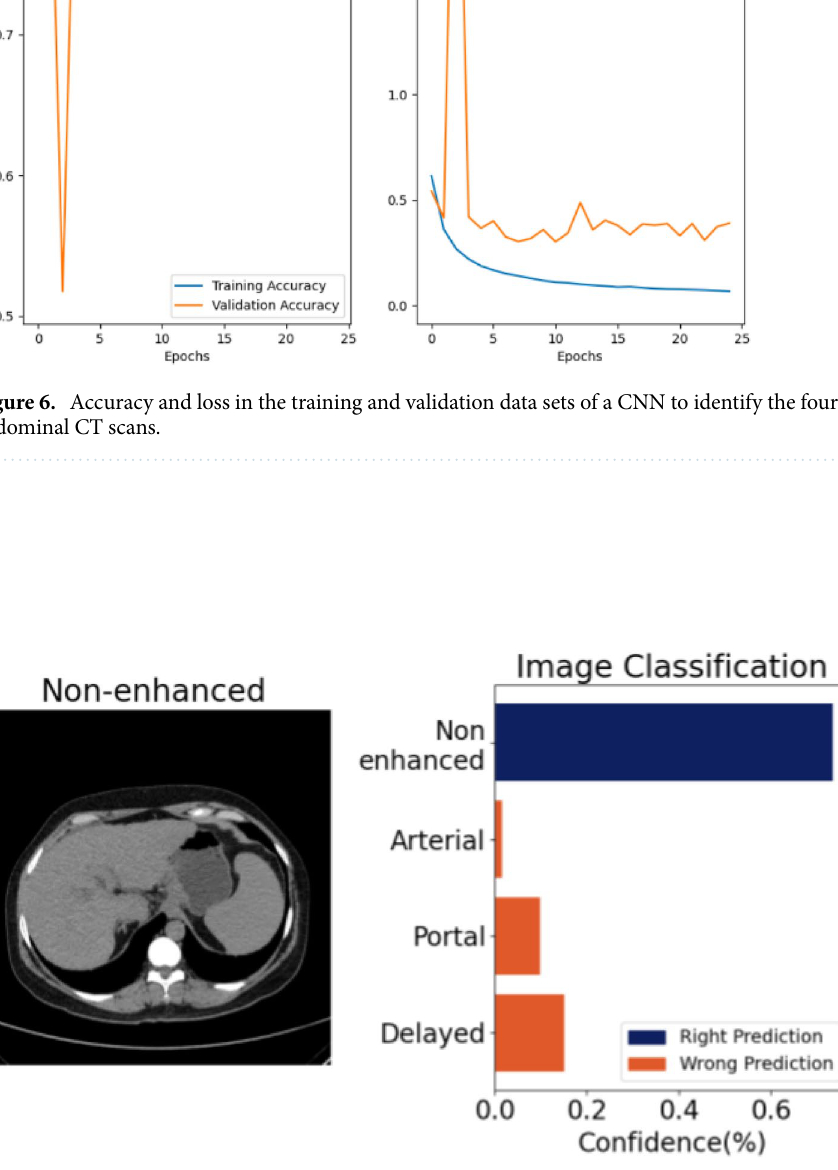
Figure 7. An example of slice with correct prediction of contrast phase. This plot shows the confidence of the slice belonging to each contrast phase. For this slice, the correct phase is non‑enhanced and the algorithm classified it correctly with 70% of confidence, while it also gave a probability of approximately 18% of belonging to delayed, 10% of belonging to portal and 2% of belonging to